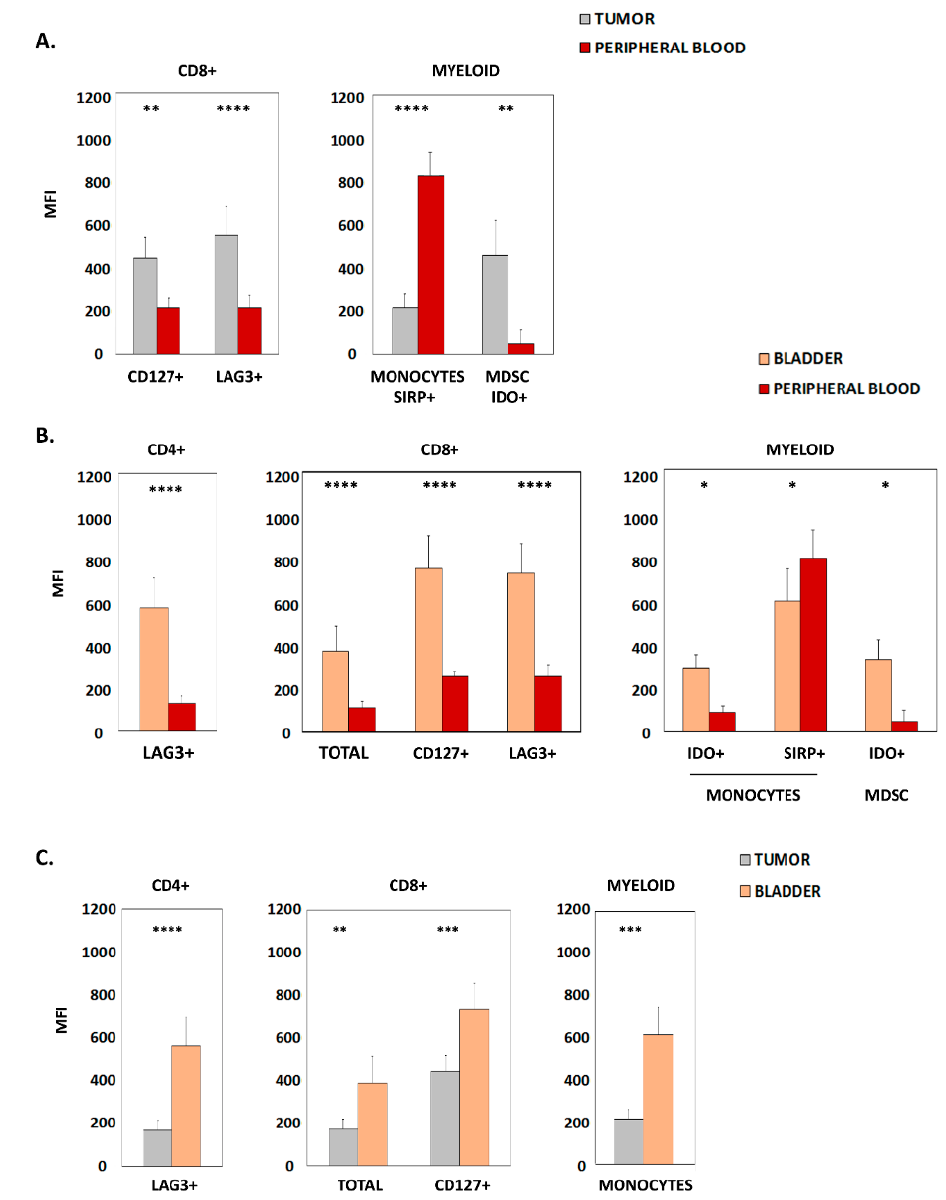
Figure 2. Markers with differential levels of expression in samples from patients with urothelial bladder carcinoma. ( A ) Graphics show the mean fluorescence intensity (MFI) of surface molecules expressed in CD8+ lymphocytes and myeloid cells from patient tumor samples and peripheral blood. ( B ) Graphics show the MFI of surface molecules expressed in CD4+ lymphocytes, CD8+ lymphocytes and myeloid cells from patient bladder tissue and peripheral blood. ( C ) Graphics show the MFI of surface molecules expressed in CD4+ lymphocytes, CD8+ lymphocytes and myeloid cells from patient bladder tissue and tumor samples. In all cases, only statistically significant results (Mean + SD of MFI) are shown; * p < 0.05; ** p < 0.01; *** p < 0.001; **** p < 0.0001. MDSC, myeloid-derived suppressor cells.